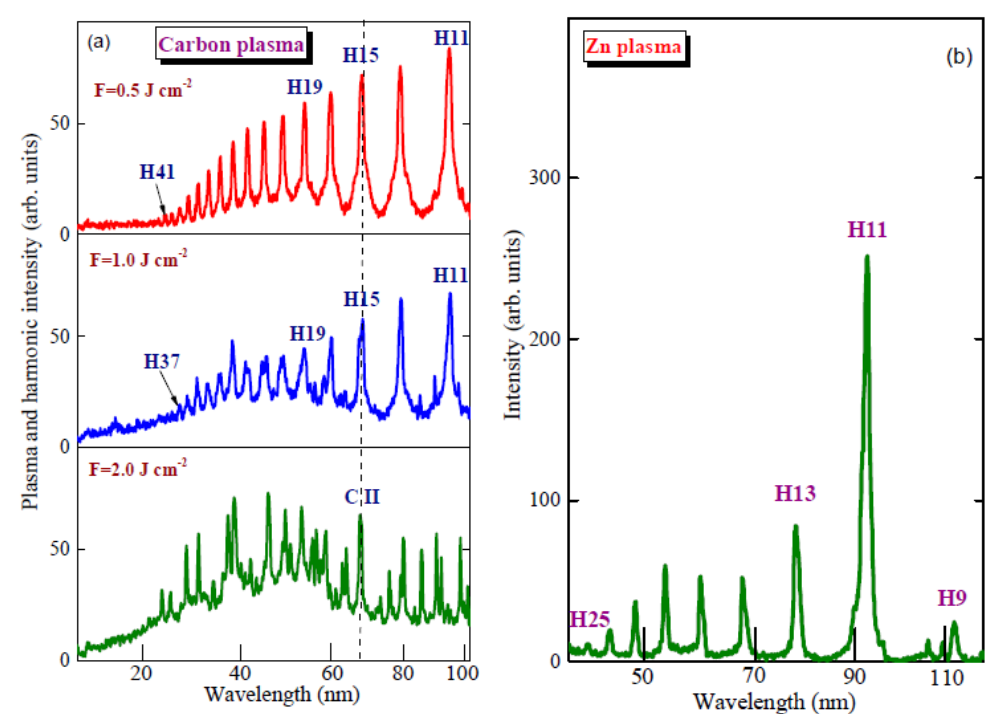
Figure 2. ( a ) Harmonic emission from the carbon plasma produced at F = 0.5 J cm − 2 (upper panel) and F = 1 J cm − 2 (middle panel) fluencies of heating 250 fs pulses. Bottom panel shows the emission spectrum from carbon plasma during ablation using 2 J cm − 2 fluence of the 250 fs pulses. The appearance of background points out the high excitation of laser-produced plasmas (LPP). The marks (H11, H15, etc.) on the panels of this and other figures refer to the harmonic orders. Dashed line corresponds to the strong emission (68.7 nm) of single charged carbon ions (CII) coinciding with H15. ( b ) Harmonic spectrum generated from zinc plasma.